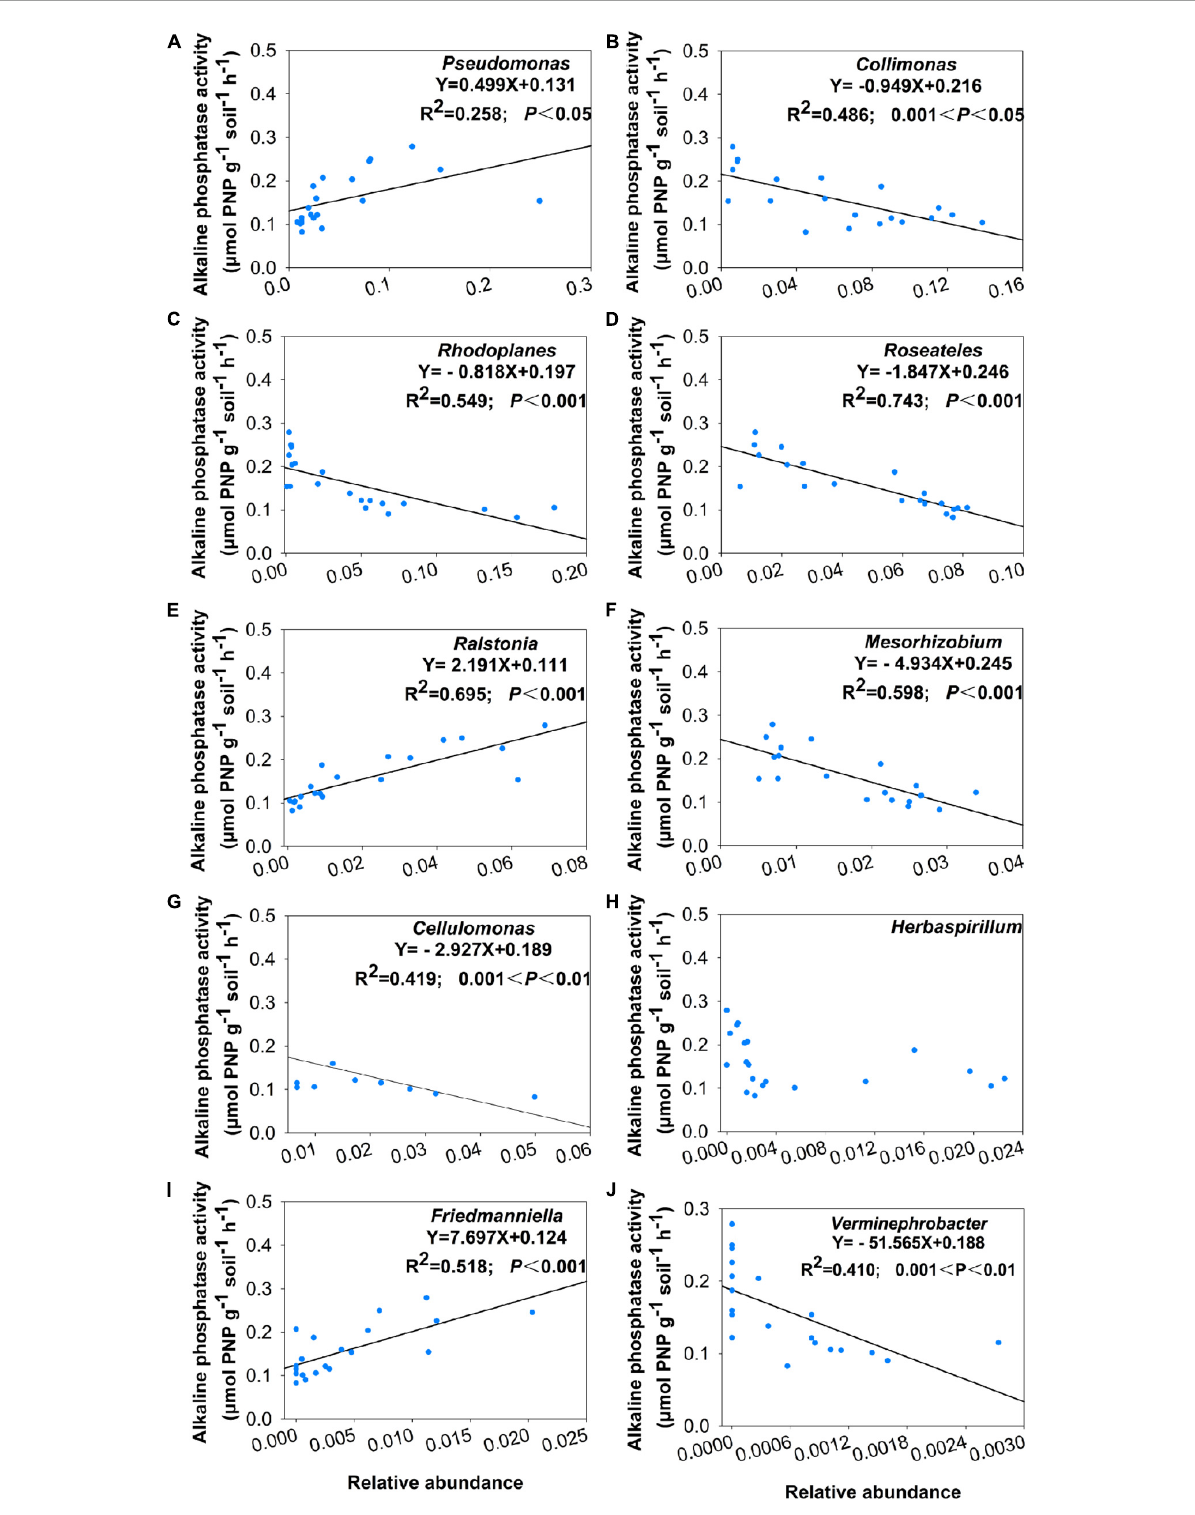
FIGURE6 Correlation between alkaline phosphatase activity and relative abundance of keystone taxa which include (A) Pseudomonas , (B) Collimonas , (C) Rhodoplanes , (D) Roseateles , (E) Ralstonia , (F) Mesorhizobium , (G) Cellulomonas , (H) Herbaspirillum , (I) Friedmanniella , and (J) Verminephrobacter